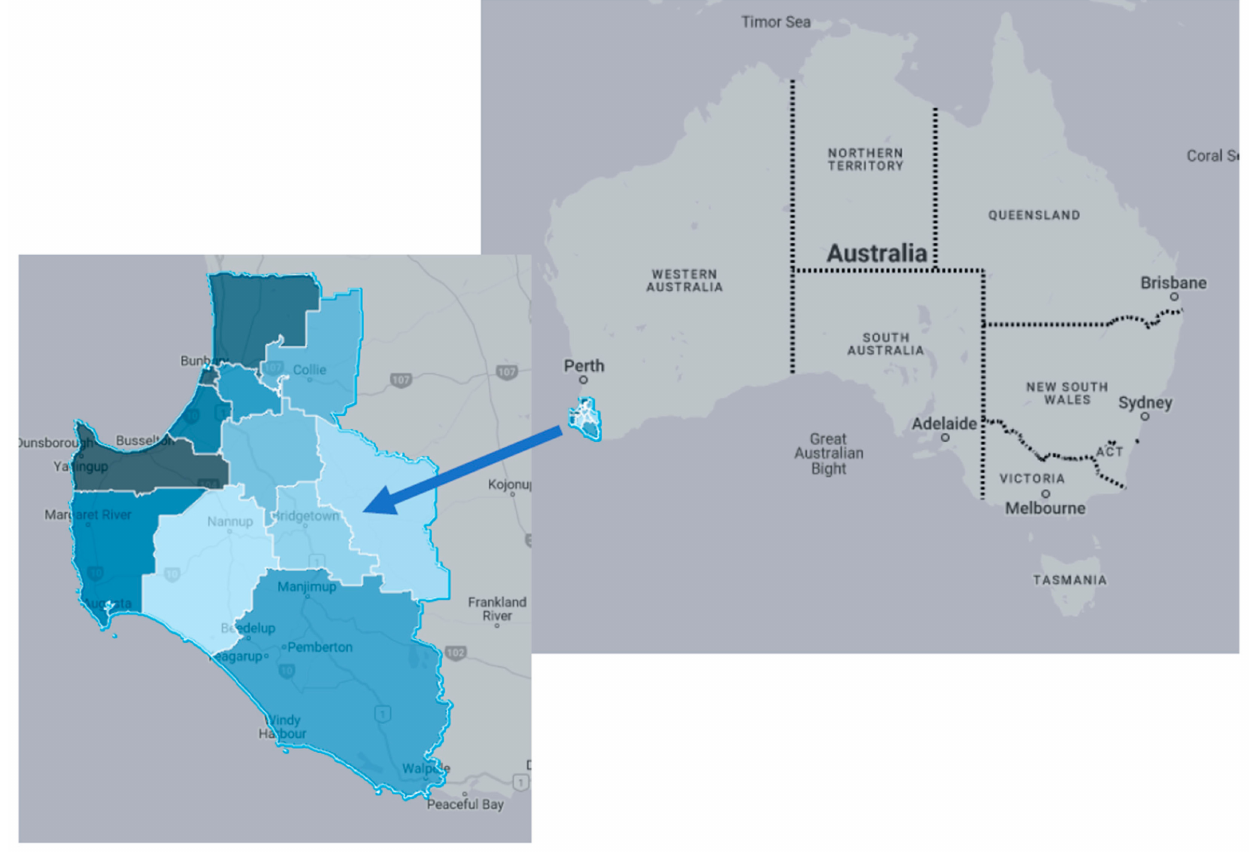
Figure 1. South West Western Australia (Adapted from REMPLAN MapBuilder, https://app.remplan. com.au/southwestregion/community/summary?state=vBxgT5VD1s37YrOhamMqmOI9tBtmDY, ac- cessed on 1 February